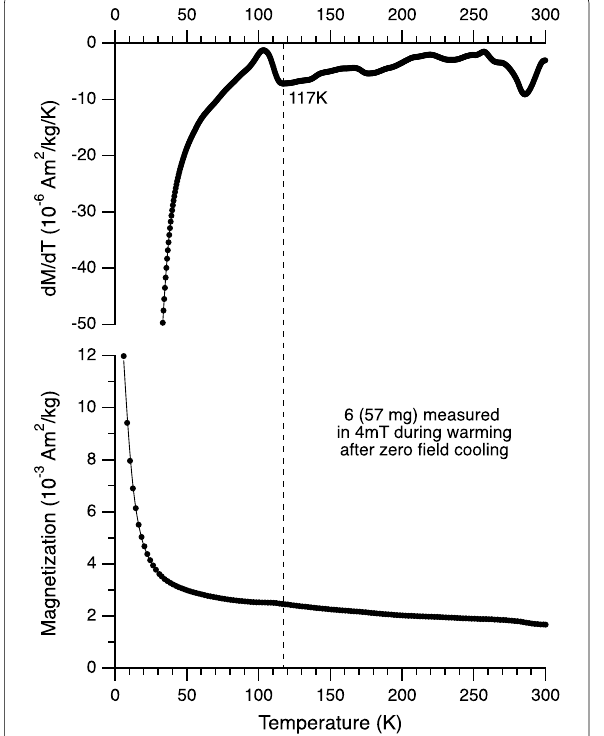
Fig. 5 Low temperature property of sample 6 measured with MPMS. Magnetization (magnetic moment) was monitored during warming in 4 mT field following zero field cooling (bottom). The curve after differentiation (above) clearly shows inflection point at ~ 117 K